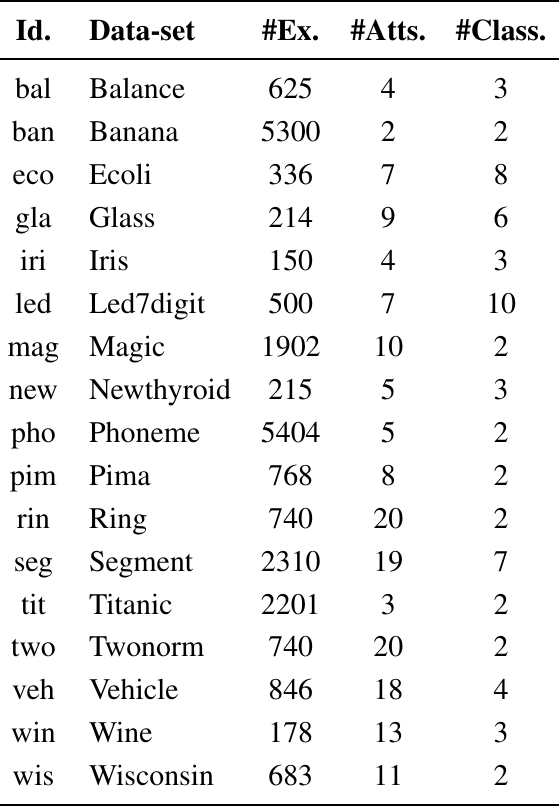
Table 1. Summary Description for the employed data-sets.